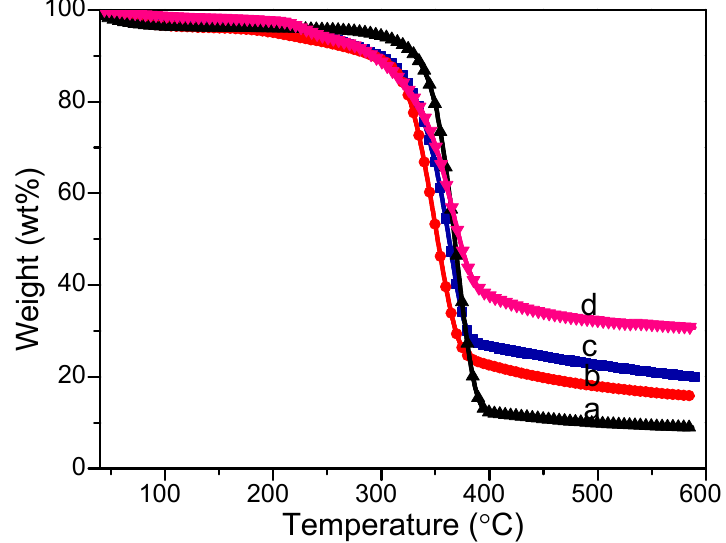
Figure 6. TGA curves of ( a ) pristine cotton fabrics, and Fe 3 O 4 -modified cotton fabrics with different amounts of ferric chloride and ferrous chloride: ( b ) 0.54 g/0.19 g; ( c ) 0.80 g/0.30 g; ( d ) 1.0 g/0.35 g.